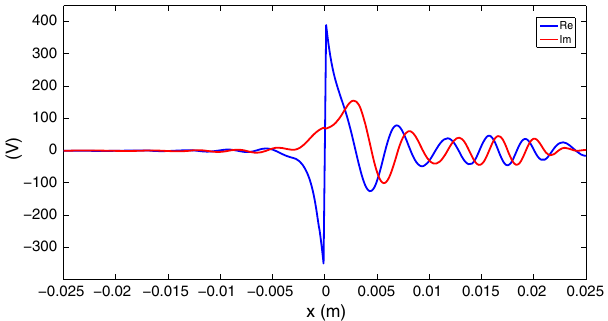
FIG. 11. The sum to p ¼ 9 of Z 0 end of the bend ( s ¼ 0 . 55 m) for kR ¼ 5 × 10 5 .